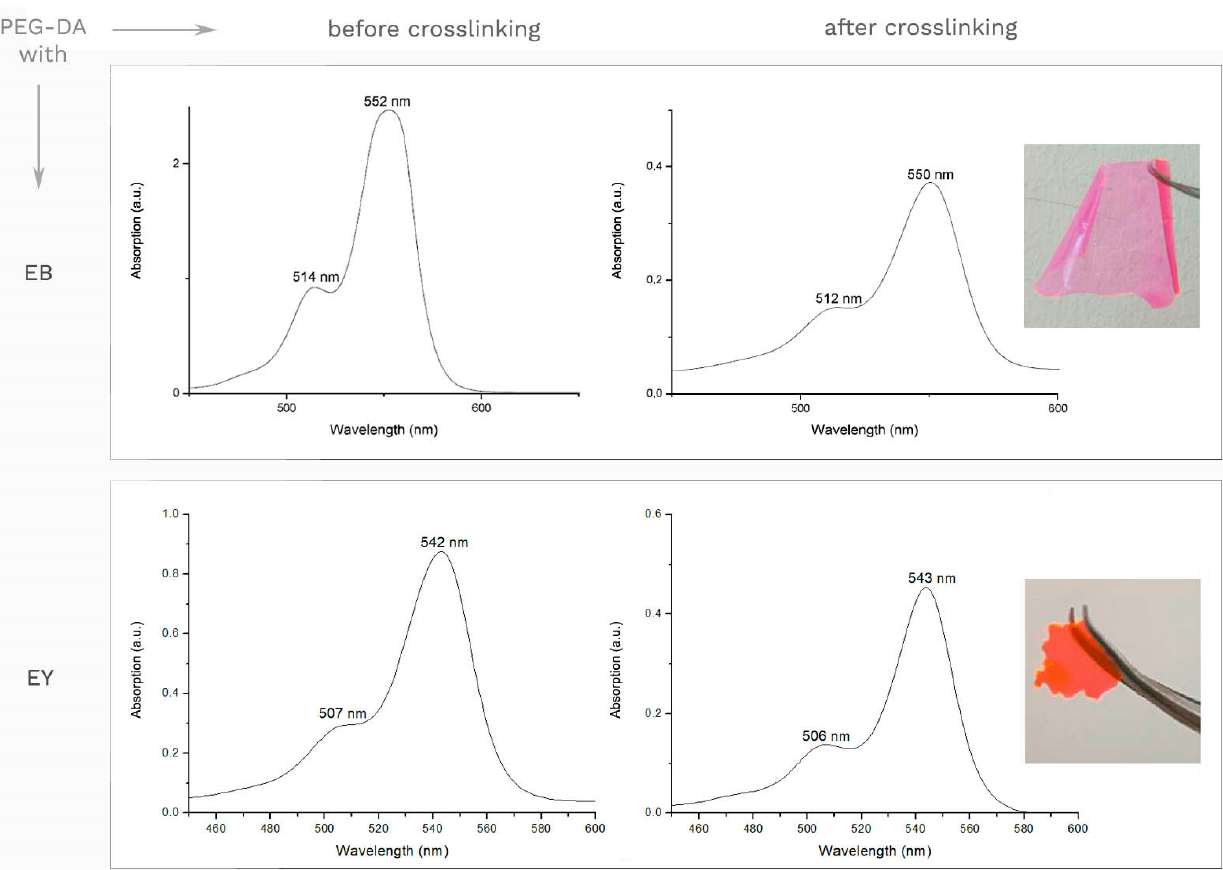
Figure 1. UV-Vis spectra for the novel PIs (EB and EY) with PEG-DA before and after crosslinking, respectively. The hydrogels with new PIs (EB and EY) feature good spectroscopic properties, allowing for use with light sources in the visible range.